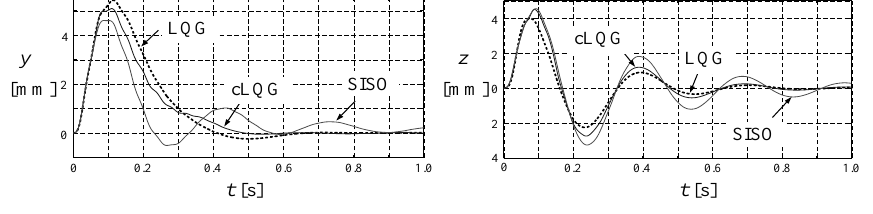
Fig. 13. System energy.